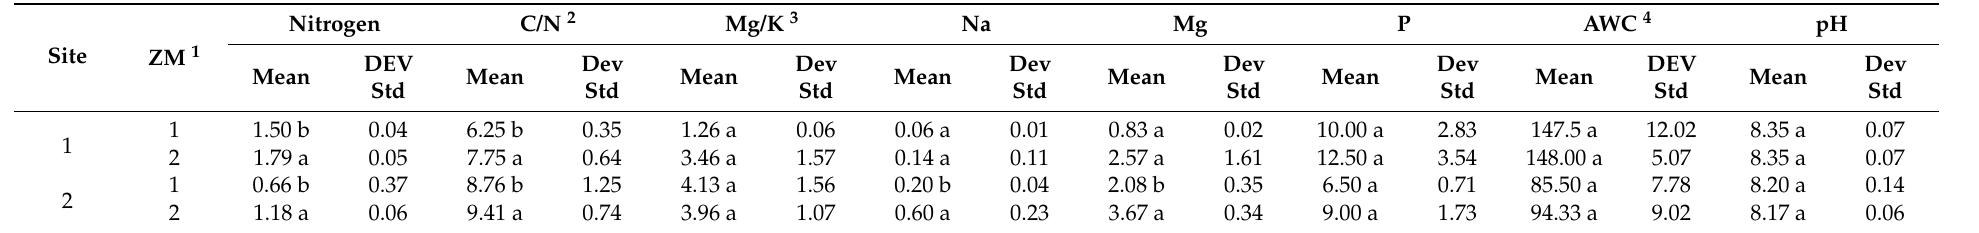
Table 10. Results of the emmeans function applied to the soil samples based on the zone management experimental factor for both sites.